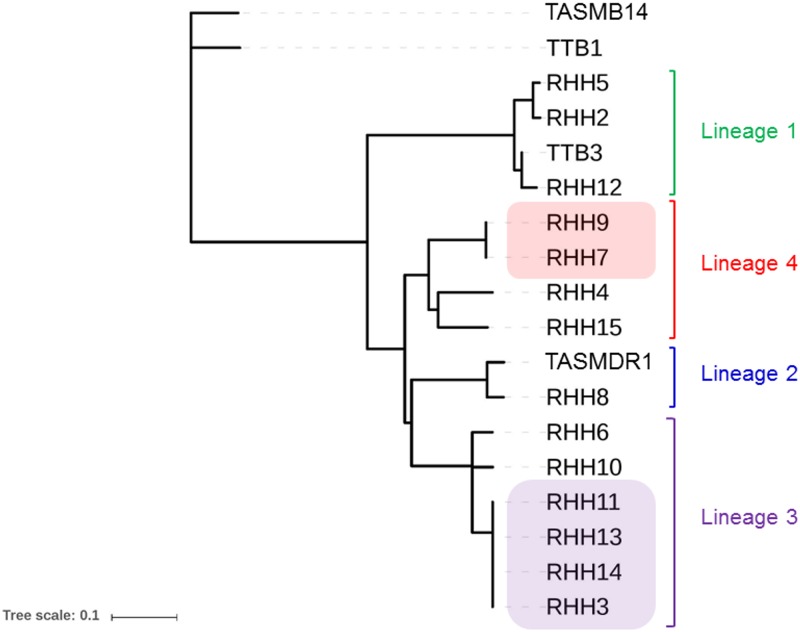
Phylogenetic relationship of Mycobacterium tuberculosis complex isolates in Tasmania from 2014 to 2016.TASMB14 and TTB1 constitute isolates of M. bovis and M. bovis BCG, respectively. The Gagneux lineage numbers are indicated for the other isolates. Lineage 2 isolate TASMDR1 is a multi-drug resistant isolate of Mycobacterium tuberculosis. Lineage 3 isolates RHH3, 11, 13 and 14 are identical (zero SNP differences with respect to one another) and form an epidemiological cluster as do Lineage 4 isolates RHH7 and RHH9. The phylogenetic tree was built using PhyML (Generalised Time Reversible substitution model).